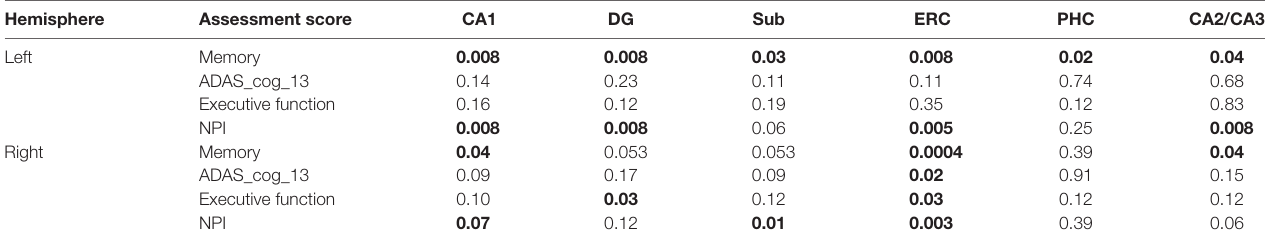
TABLE 6 | Associations between assessment scores and volume of the hippocampal subfields for A+ group ( p < 0.05, FDR correction).